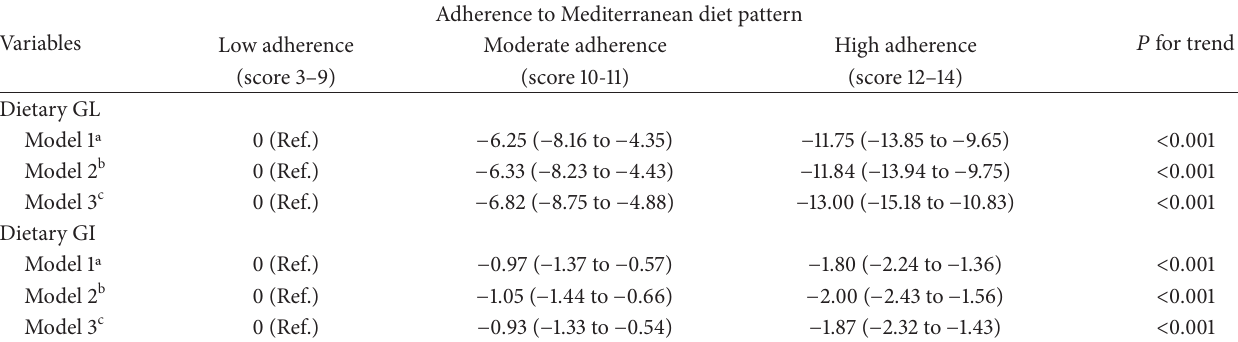
Table 3: Regression coefficients and 95% CI for GL and GI according to categories of adherence to MeDiet pattern at one year of follow-up ( 𝑛 = 2866